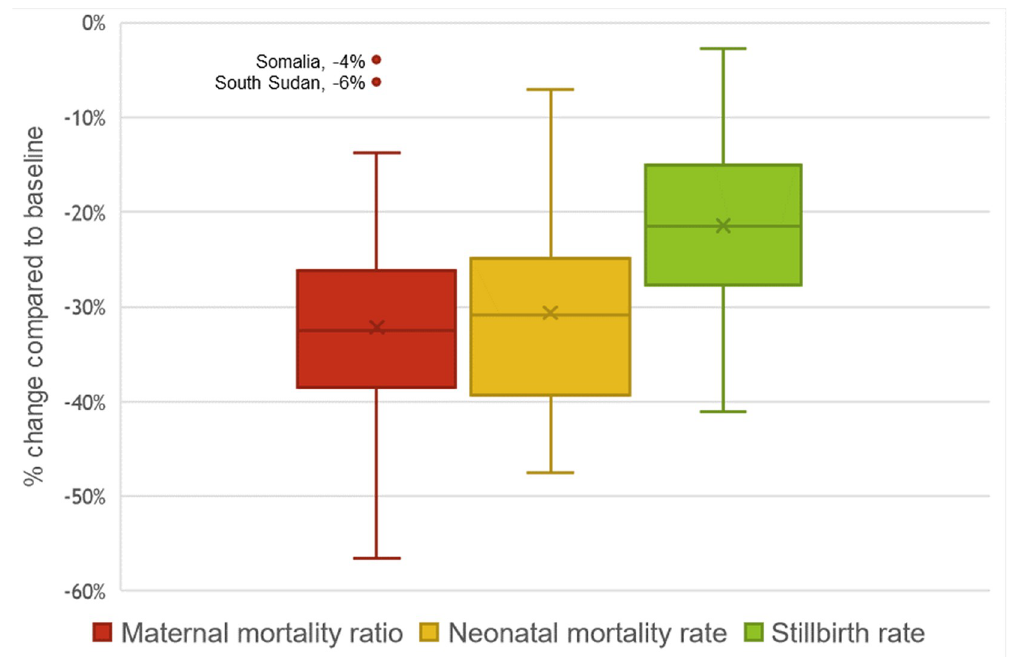
Fig 4. Boxplot of estimated mortality change quantified in 81 LMICs comparing 2020 (endline) to 2016 (baseline). Bars represent the 25th, 50th (middle), and 75th percentiles for the percent change in MMR, neonatal mortality rate, and stillbirth rate. The outliers include Somalia and South Sudan, which were estimated to have very modest reductions in MMR. LMIC, low- and middle-income country; MMR, maternal mortality ratio.